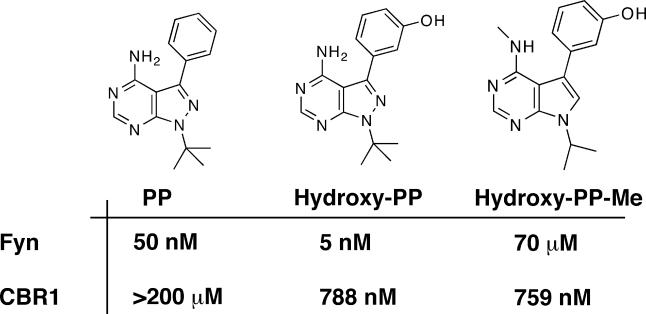
IC50 Values against CBR1 and Fyn Kinase Are Tabulated for PP Derivatives